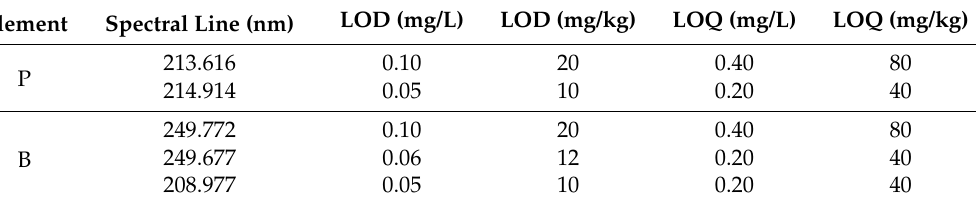
Table 8. Detection and quantification limits using a constitutive blank of 5 mL H 2 SO 4 + 1 mL HNO 3 . LODs and LOQs were calculated as described in Section 3.2.